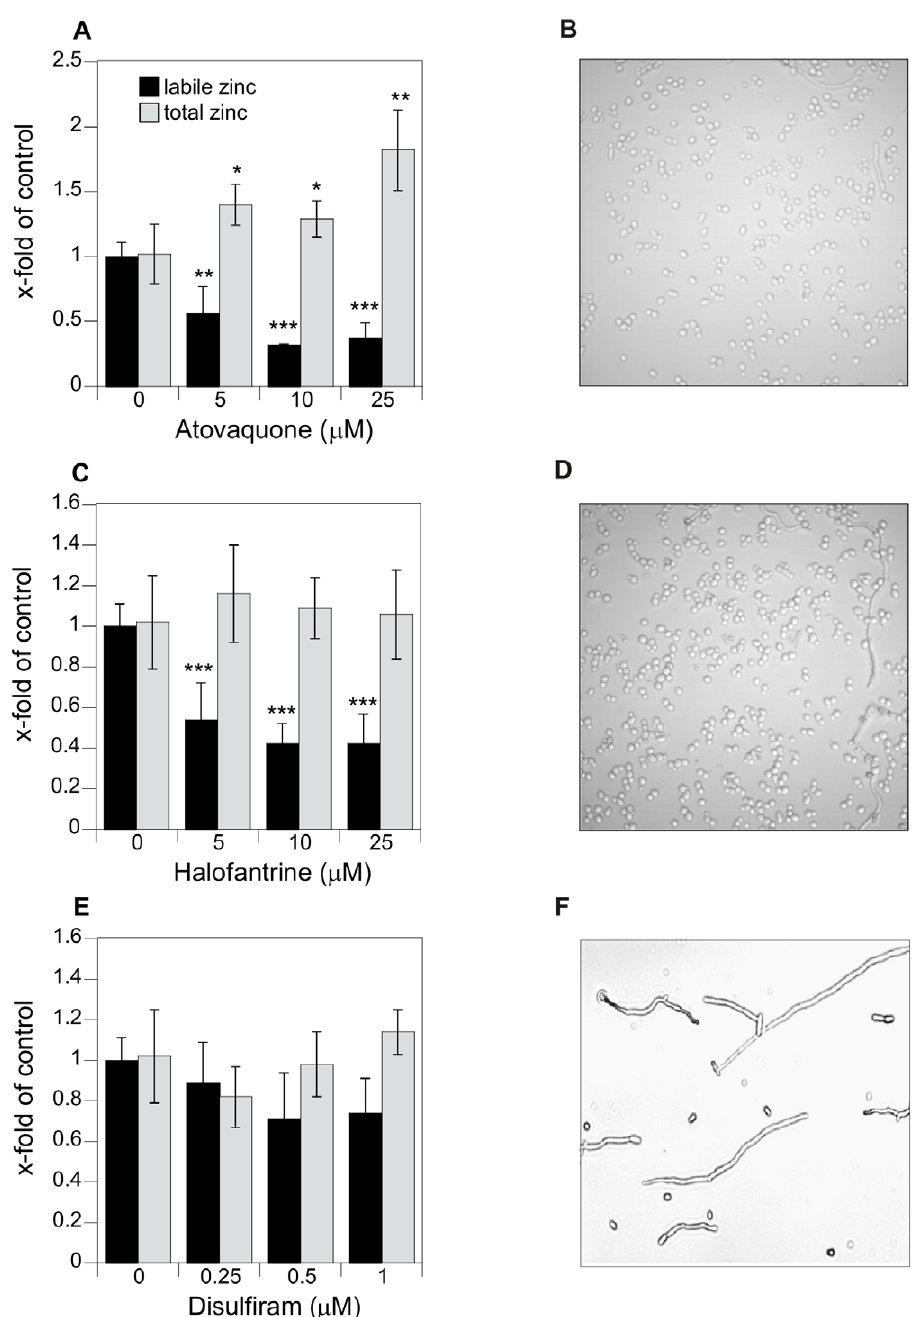
Figure 7. Total and labile zinc and cell morphology of C.albicans . Candida cells treated with A, B) Atovaquone, C, D) Halofantrine or E, F) Disulfiram and incubated at 30 u C for 20 hours. 100 m l aliquots were immediately used for flow cytometry, the remaining culture was used for ICP-MS analysis. Light microscopy images were obtained from cells treated with 25 m M atavaquone and halofantrine and 1 m M disulfiram using standard protocols. Error bars represent standard deviation (SD). Level of significance are characterized as followed (* P , 0.01, ** P , 0.001, *** P , 0.0001, not significant P . 0.05). Statistical significance was tested by one-way ANOVA.